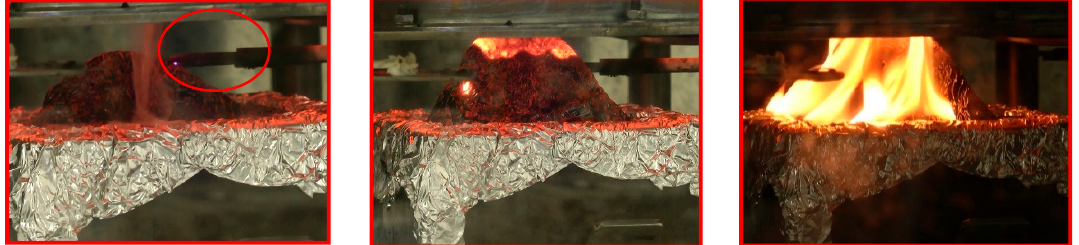
Figure 10. Pictures of PEEK taken at ( left ) 307 s, ( middle ) 852 s and ( right ) 889 s when it is subjected to an incident heat flux of 50 kW/m² using the MLC.